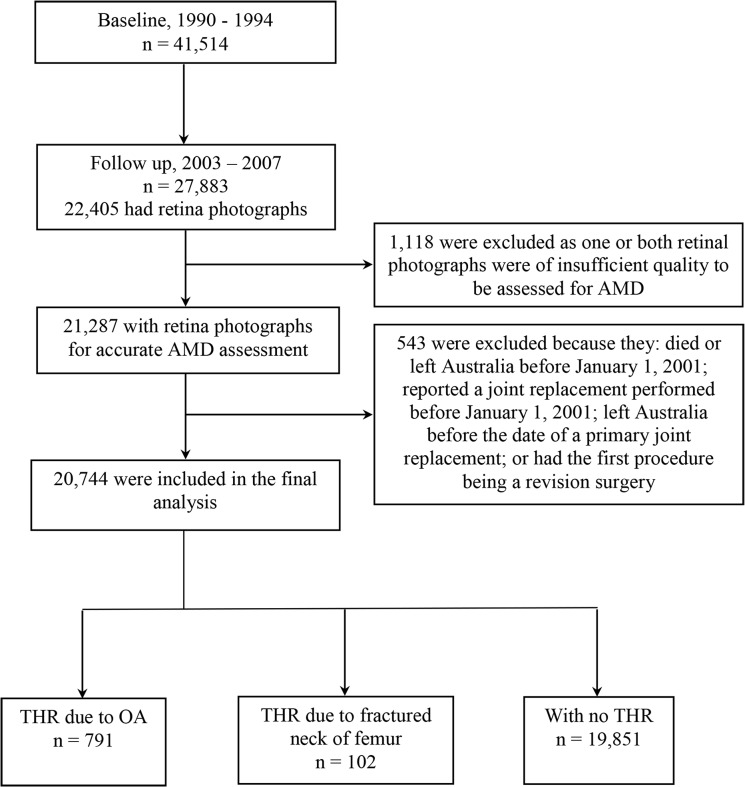
Study flowchart.